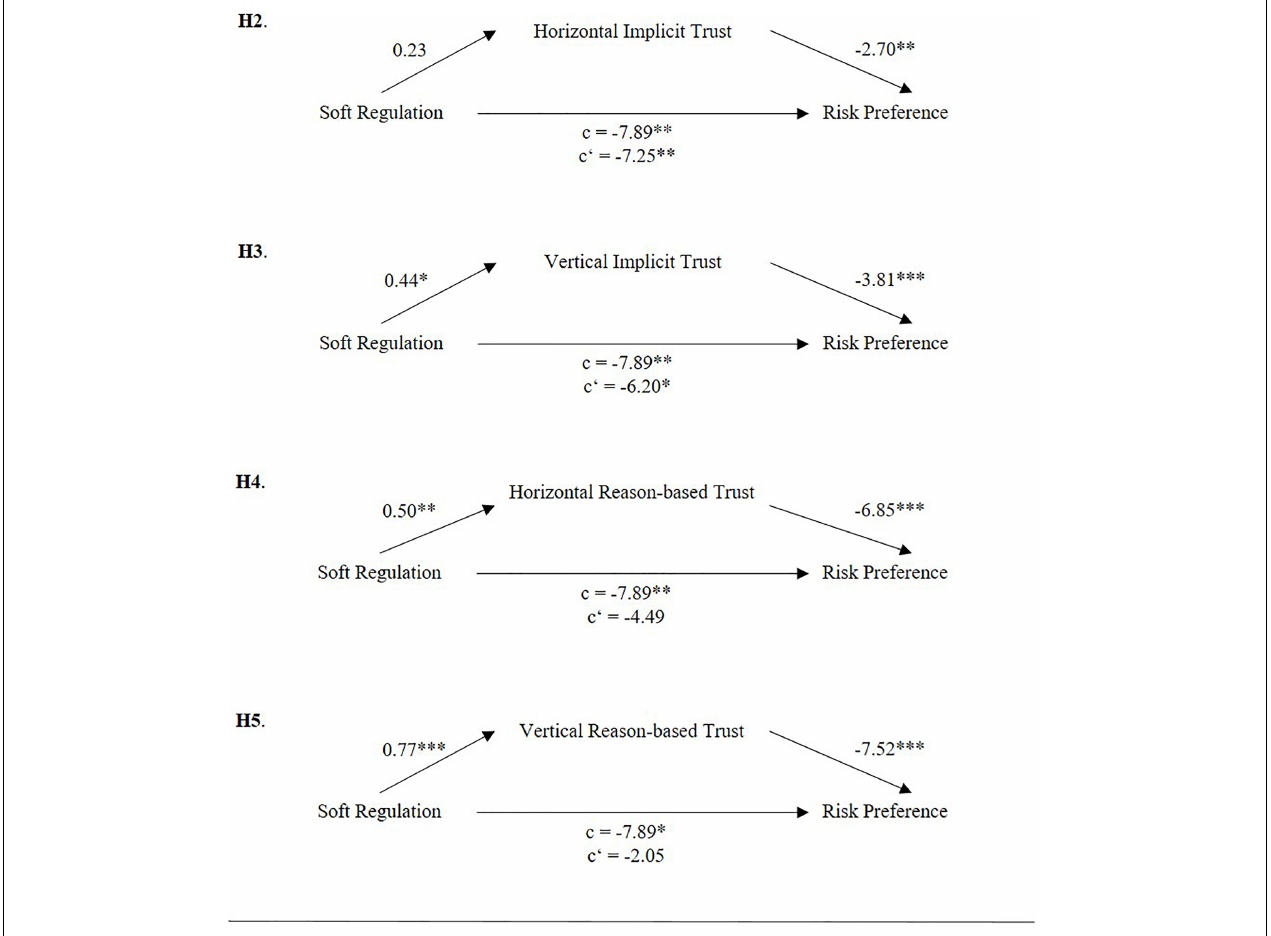
FIGURE 4 | Results of mediation